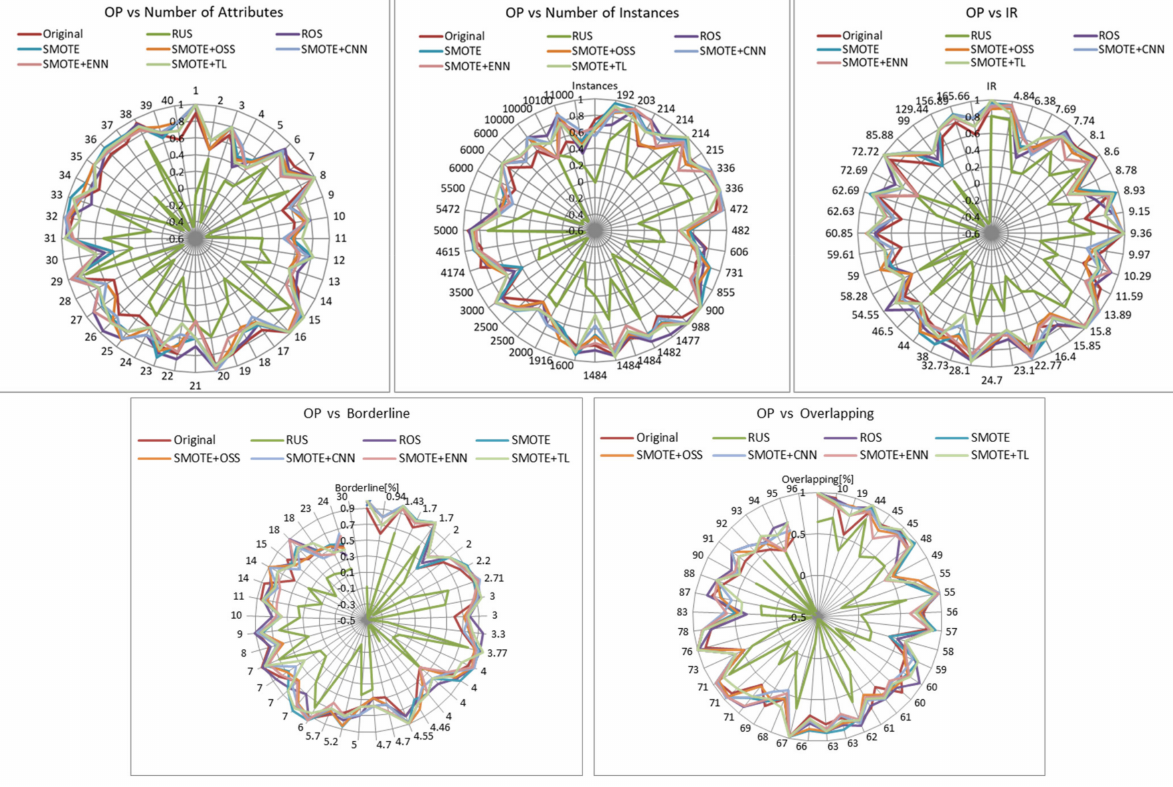
Figure 8. Influence of dataset characteristics on OP for all resampling